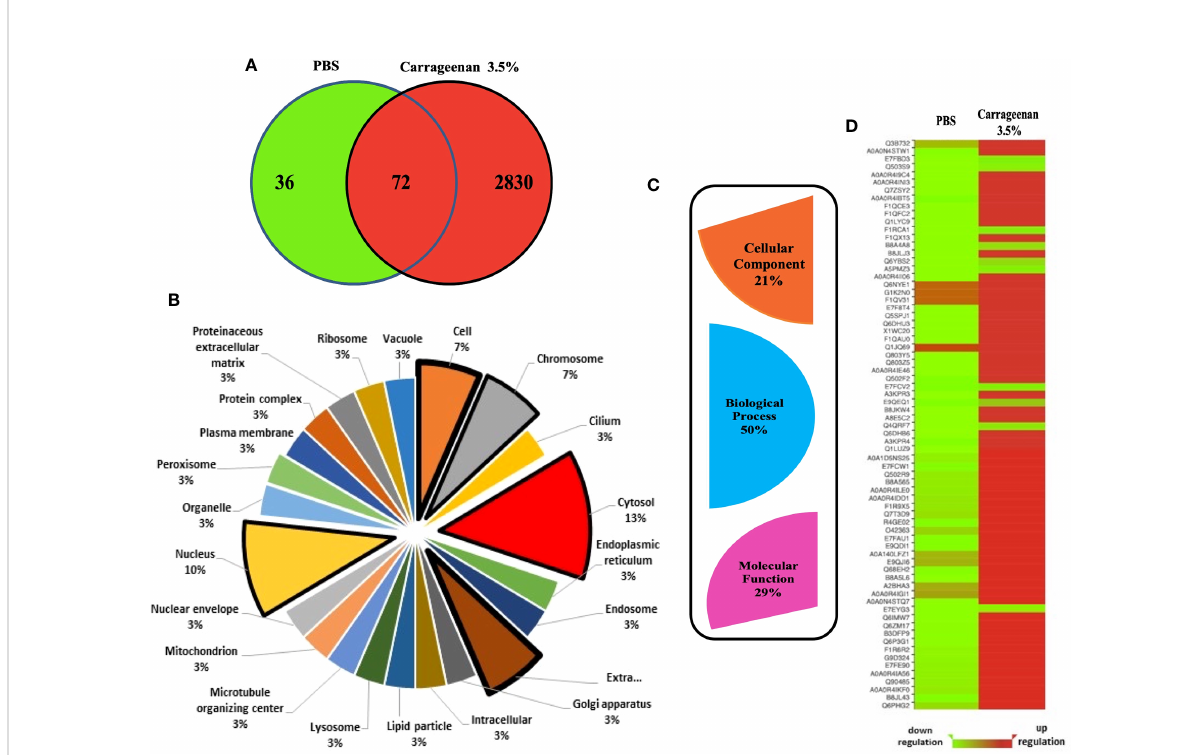
FIGURE 5 Analysis of proteomics data. (A) Venn diagram created using the program Venny (http://bioinfogp.cnb.csic.es/tools/venny/index.html) showing the total number of proteins differentially expressed after 4h between the PBS and l -CGN (3.5%) injected fi sh. Seventy-two shared proteins between the three replicates analyzed per group were further analyzed. Following identi fi cation, groupings were done according to important proteins in each set involved in the process of l -CGN-induced in fl ammatory reaction in zebra fi sh. Protein interactions were also investigated with regards to their (B) Cellular component and (C) GO Domain using the STRING software (version 5.18). (D) Heatmap showing the raw data (score) of the 72 proteins identi fi ed in plasma extracted from the PBS and l -CGN induced fi sh. Note the strong protein differential expression achieved in the l -CGN treated zebra fi sh. The visual guide is located at the